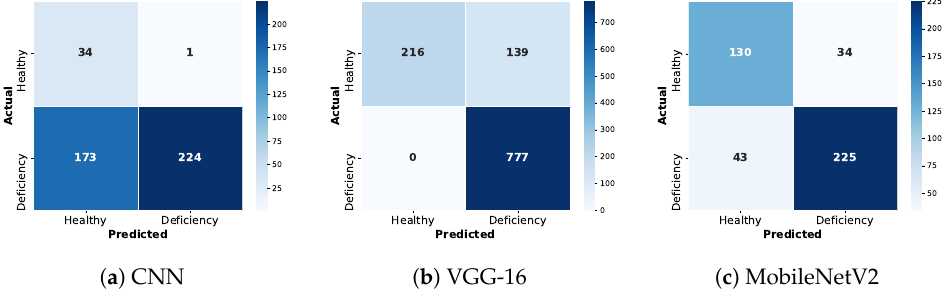
Figure 8. Confusion matrices on the nutrient deficiency based on 432 validation images.